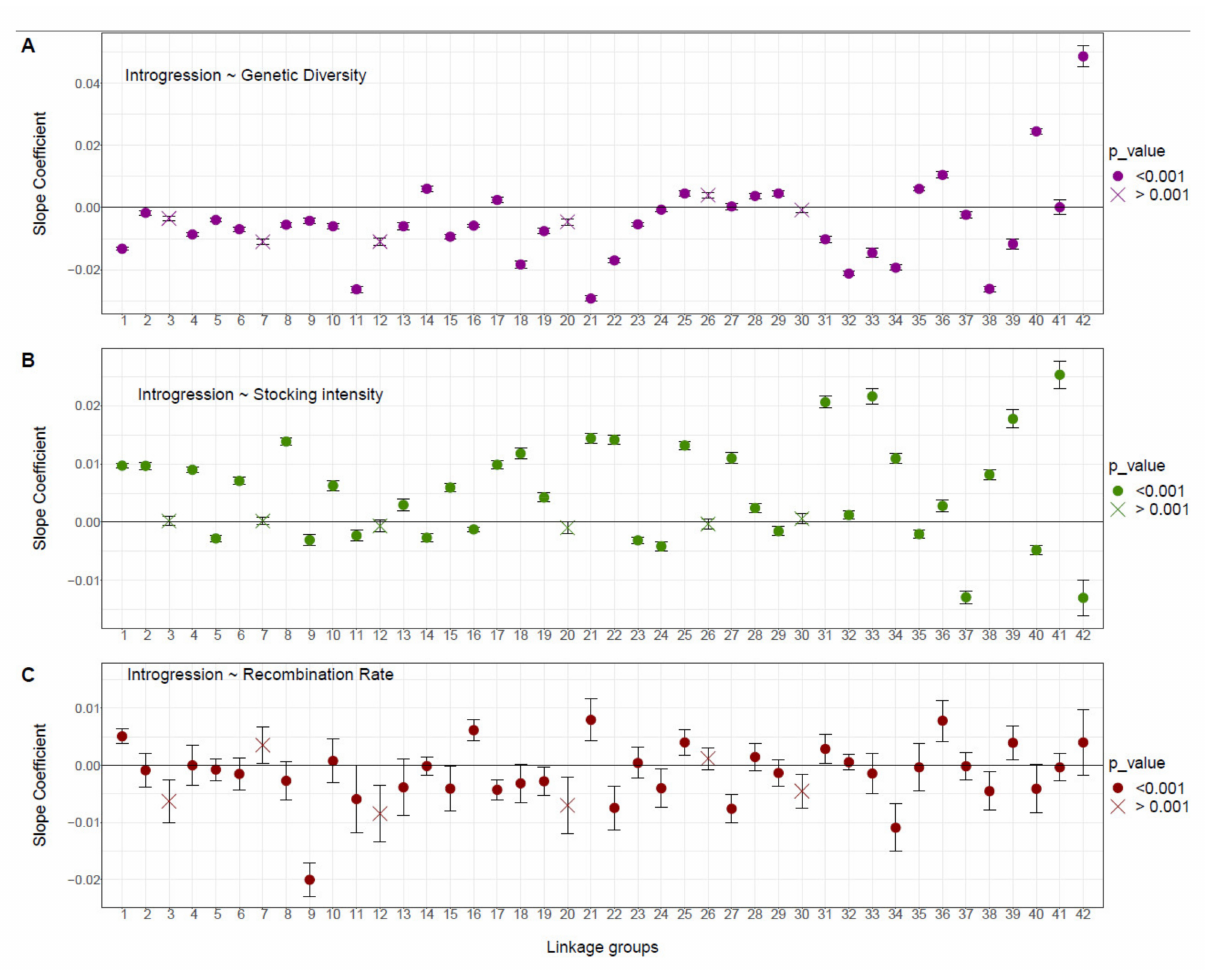
Figure 4. Relationship between the domestic ancestry rate and ( A ) genetic diversity, ( B ) stocking intensity and ( C ) local recombination rate for each linkage group. Slope coefficients of the GLM model are reported for each 42 Brook Charr linkage group. Dots represent the significance of each model with circles and crosses representing p < 0.001 and p > 0.001, along with the 95% confidence interval,